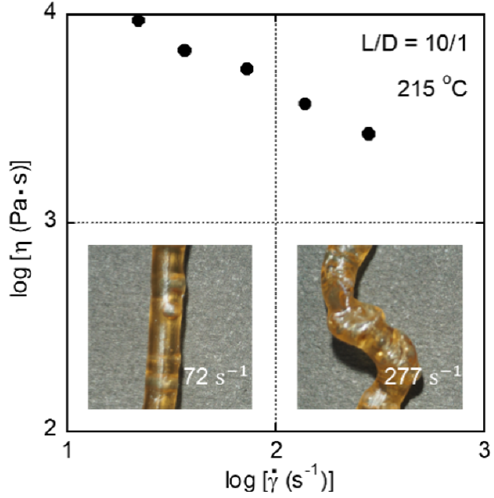
Figure 5. Steady-state shear viscosity η strand extruded at 1000 s − 1 through a die with an L/D ratio of 10/1. The solid line represents the complex shear viscosity η ∗ ( ω ) .